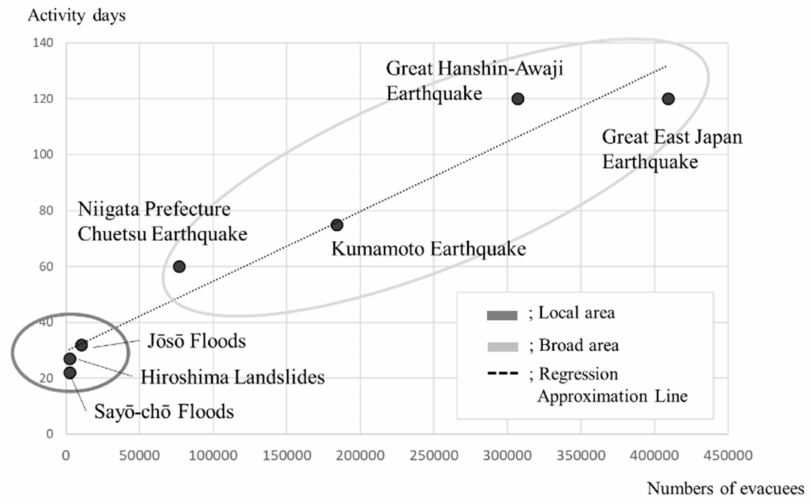
Figure 6. Plot of the team activity days and the maximum number of